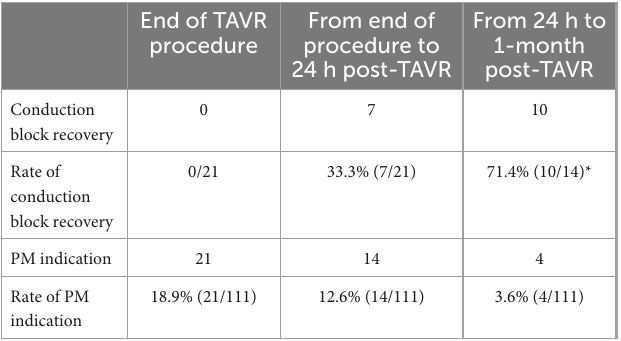
TABLE 4 Recovery of conduction block and indication of pacemaker (PM) during different